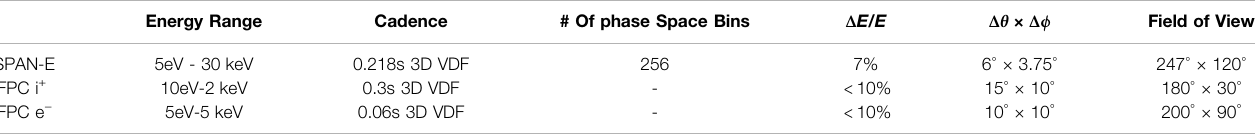
TABLE 1 | Heritage electrostatic analyzer for electrons (SPAN-E) measurement performance and predicted performance requirements of proposed ion and electron Integrated Field-Particle Correlator (IFPC) instruments. Energy